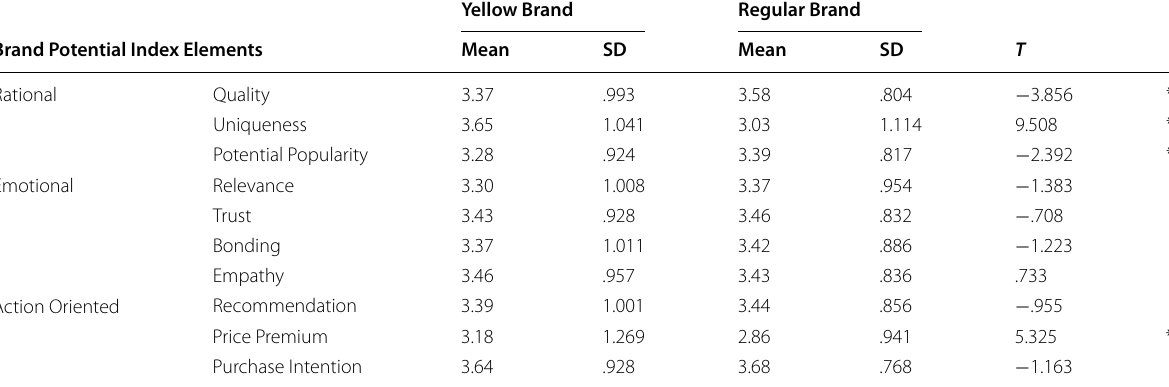
Table 2 Yellow and Regular Brand T-tests for Brand Potential Index Elements